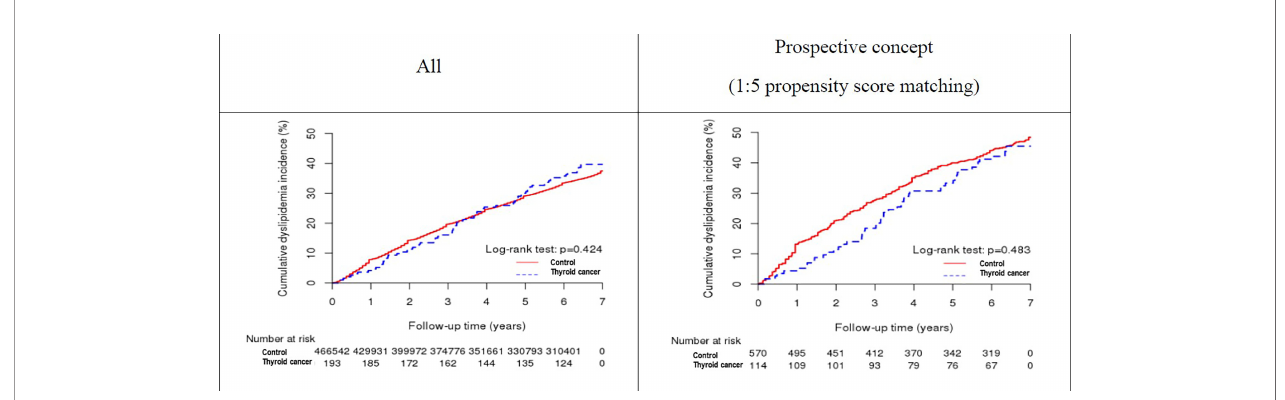
FIGURE 2 | Kaplan-Meier curves showing dyslipidemia risk in patients with thyroid cancer.